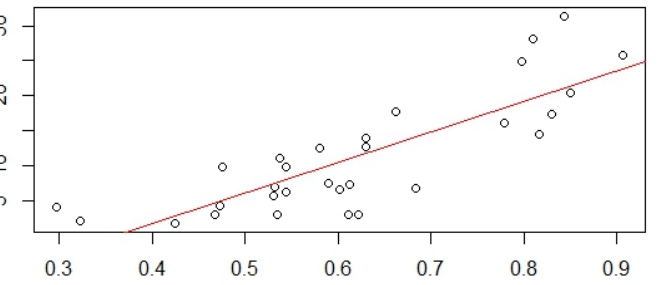
Figure 2: Lifelong Learning (Eurostat) Versus Internet Usage (Digital